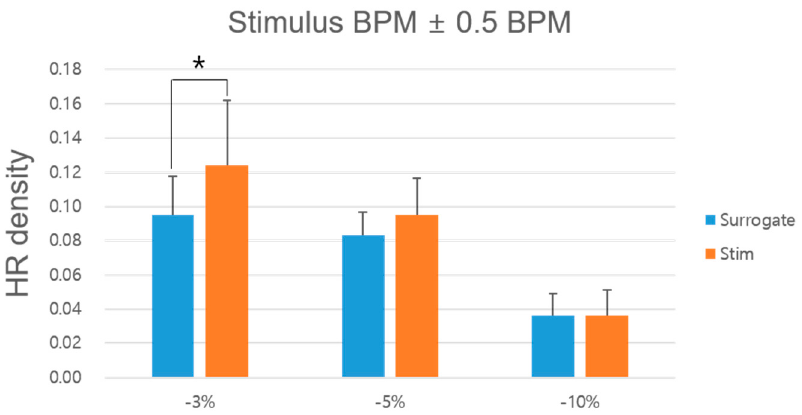
Figure 6. HR densities in stimulus BPM ± 0.5 BPM for each experimental condition. * p < 0.01 between the baseline and stimulation conditions (Wilcoxon rank-sum test). HR, heart rate. Table 2. Distribution of heart rate densities (mean ± standard